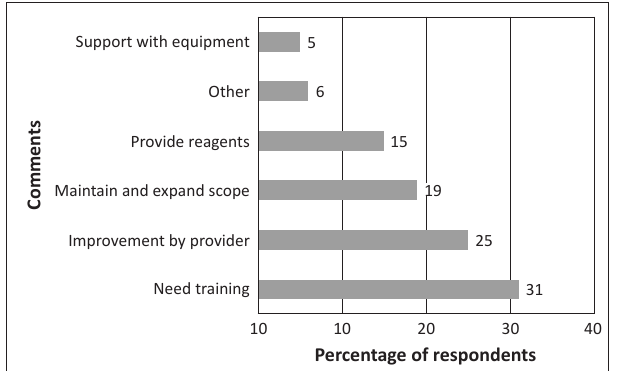
FIGURE 5: Categorised comments by participating